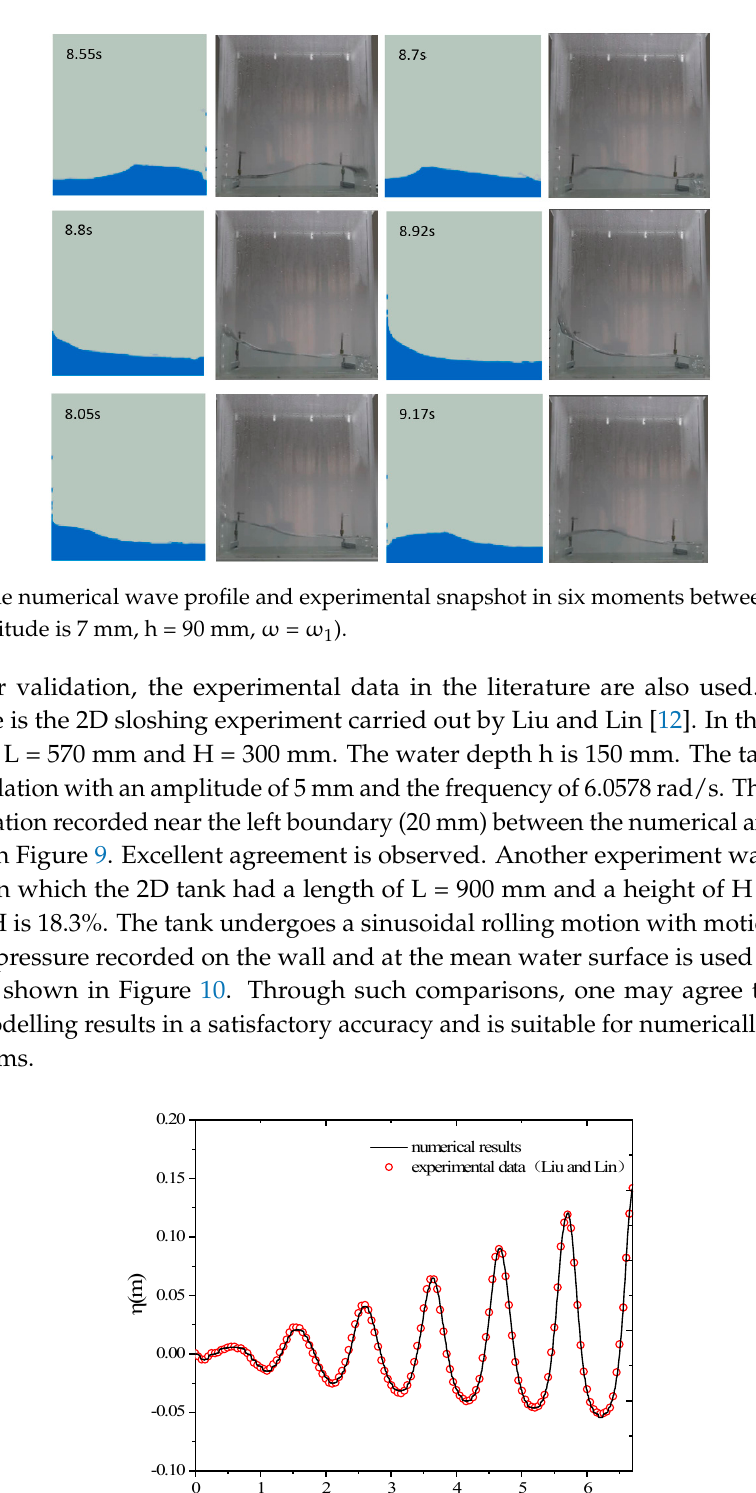
Figure 7. The Fast Fourier Transformation of the time history of the experimental and numerical pressure (amplitude is 7 mm, h = 90 mm, ω a = 0.5 ω 1 , ω b = 0.8 ω 1 ).